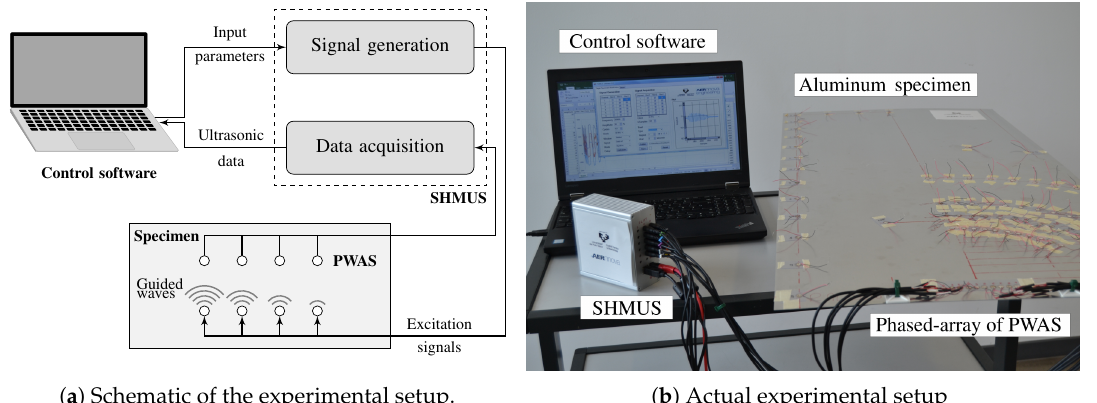
Figure 5. Experimental setup used in the transmission beamforming tests.